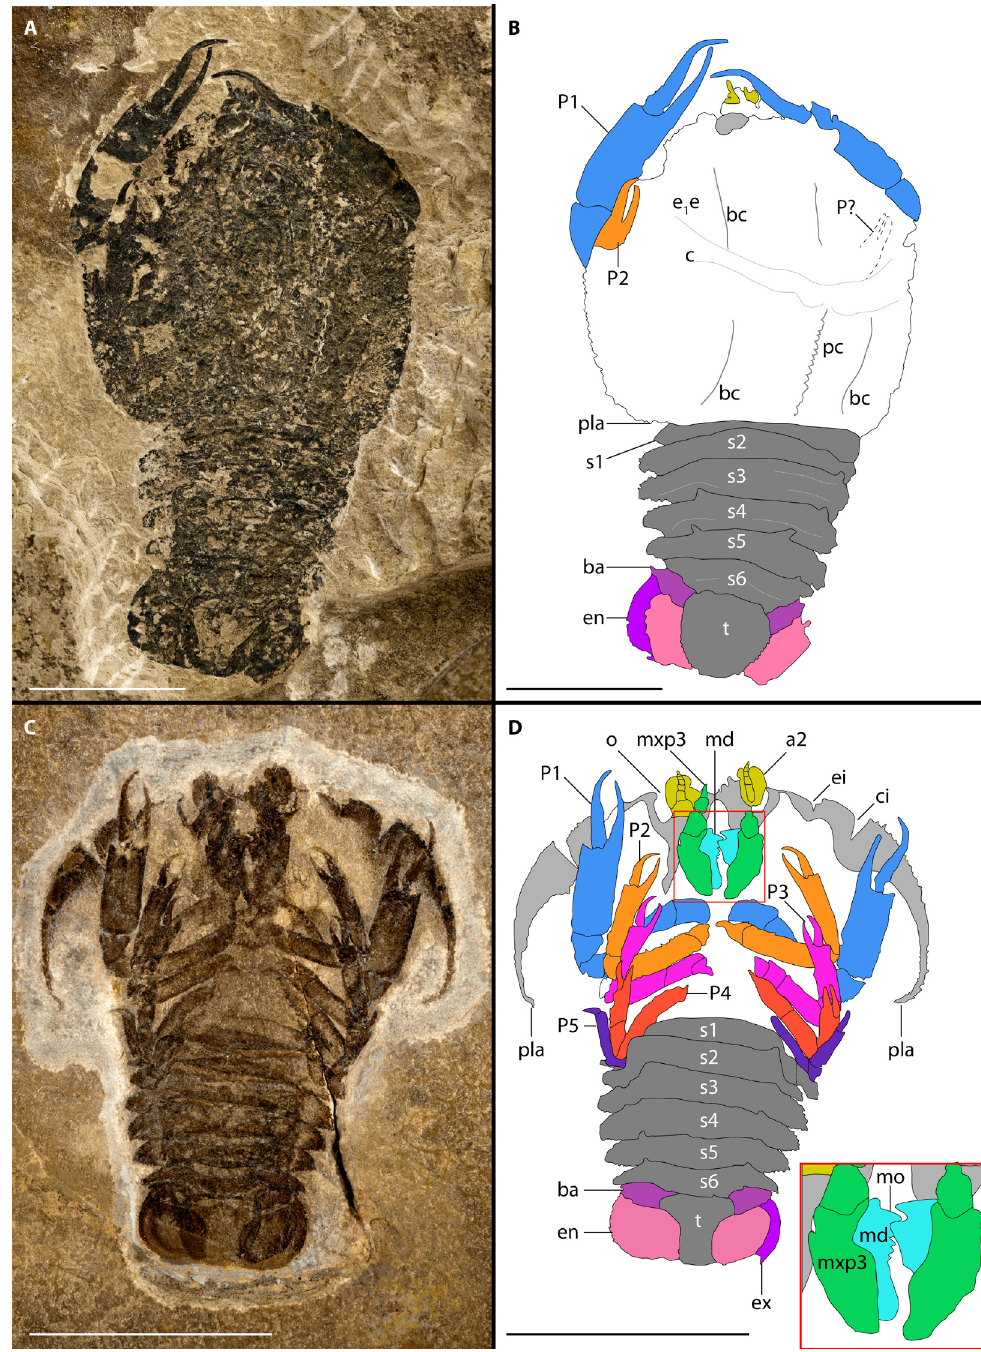
Fig. 1. Rosenfeldia triasica Garassino, Teruzzi & Dalla Vecchia, 1996 from the Upper Triassic (Norian) of Mount Auda, Italy. A–B . Holotype, MFSNgp 16178, dorsal view, cross-polarized light (A) and interpretative line-drawing (B). C–D . Specimen MFSNgp 40312, ventral view, cross-polarized view (C) and interpretative line-drawing (D). Abbreviations: a2 = antenna; ba = uropodal basipodite; bc = branchial carina; c = postcervical groove; ci = postcervical incision; e e = cervical groove; en = uropodal 1 endopod; ei = cervical incision; ex = uropodal exopod; md = mandible; mo = mandibular molar process; mxp3 = third maxilliped; o = ocular incision; P1–P5 = pereiopods 1 to 5; P? = indeterminate pereiopod; pc = postcervical carina; pla = posterolateral angle; s1–s6 = pleonites 1 to 6; t = telson. Scale bars: A–B = 10 mm; C–D = 20 mm. Photographs: D. Audo, ©